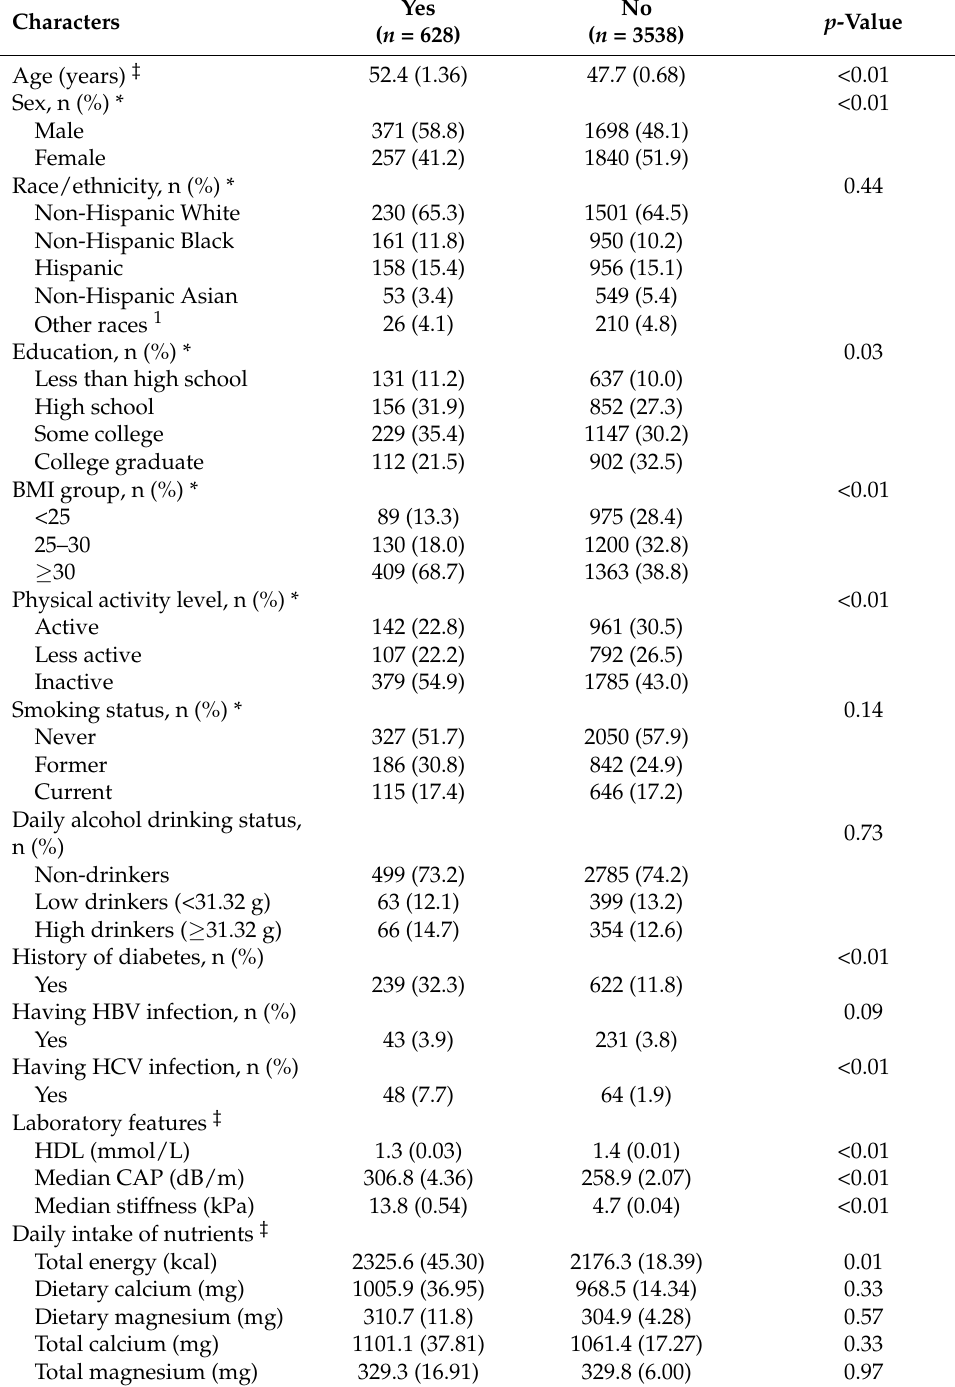
Table 1. Participant characteristics by significant liver fibrosis status, National Health and Nutrition Examination Survey (NHANES)